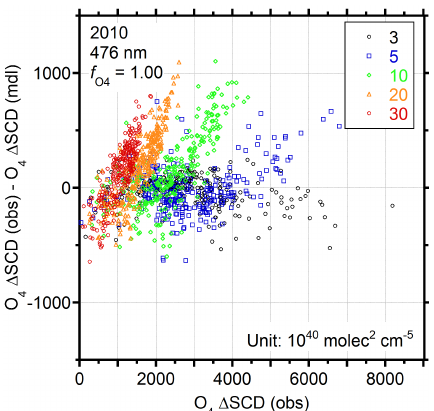
of 1.00 is assumed in the MAX-DOAS retrieval. 4